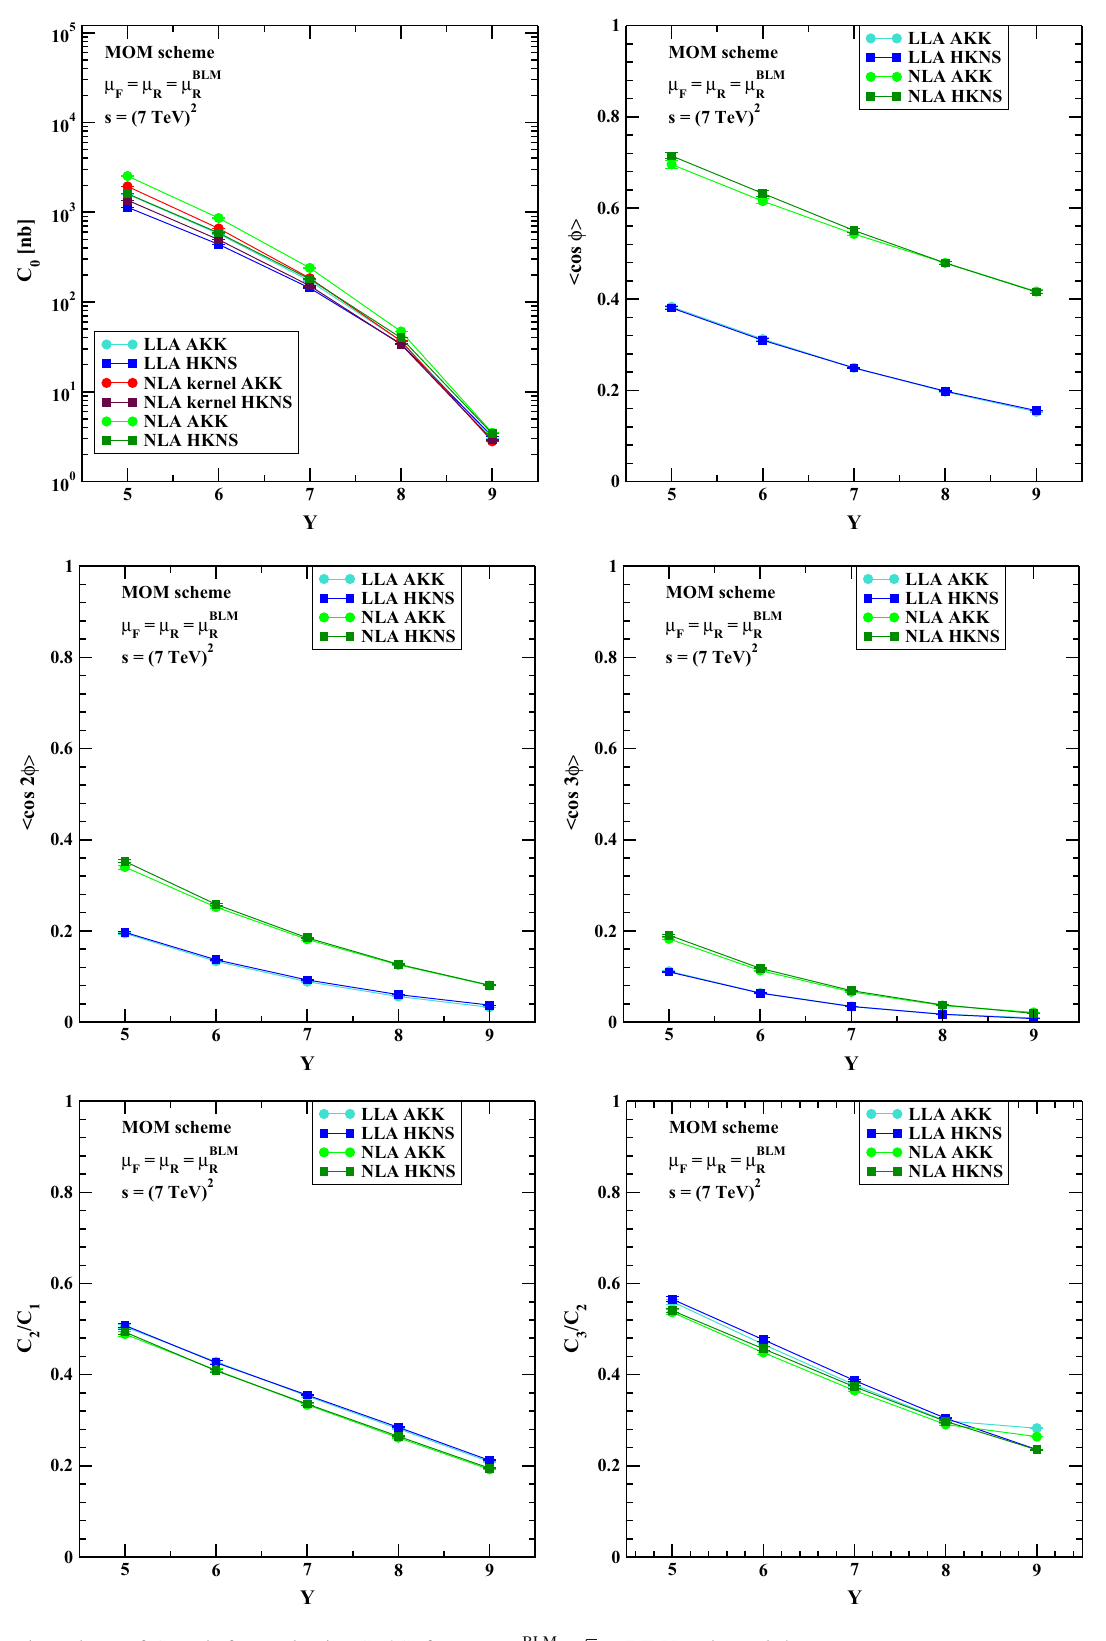
Fig. 9 Y -dependence of C 0 and of several ratios C m / C n for μ F = μ BLM